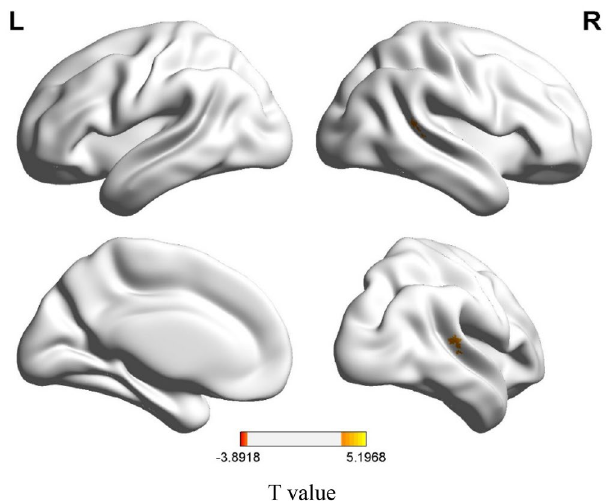
Figure 2. Differences in whole-brain voxel-wise ALFF features between CI patients and HC. The thresholds were p < 0.001 at the voxel level and p < 0.05 at the cluster level with GRF corrections for multiple comparisons. The colour bar represents the t